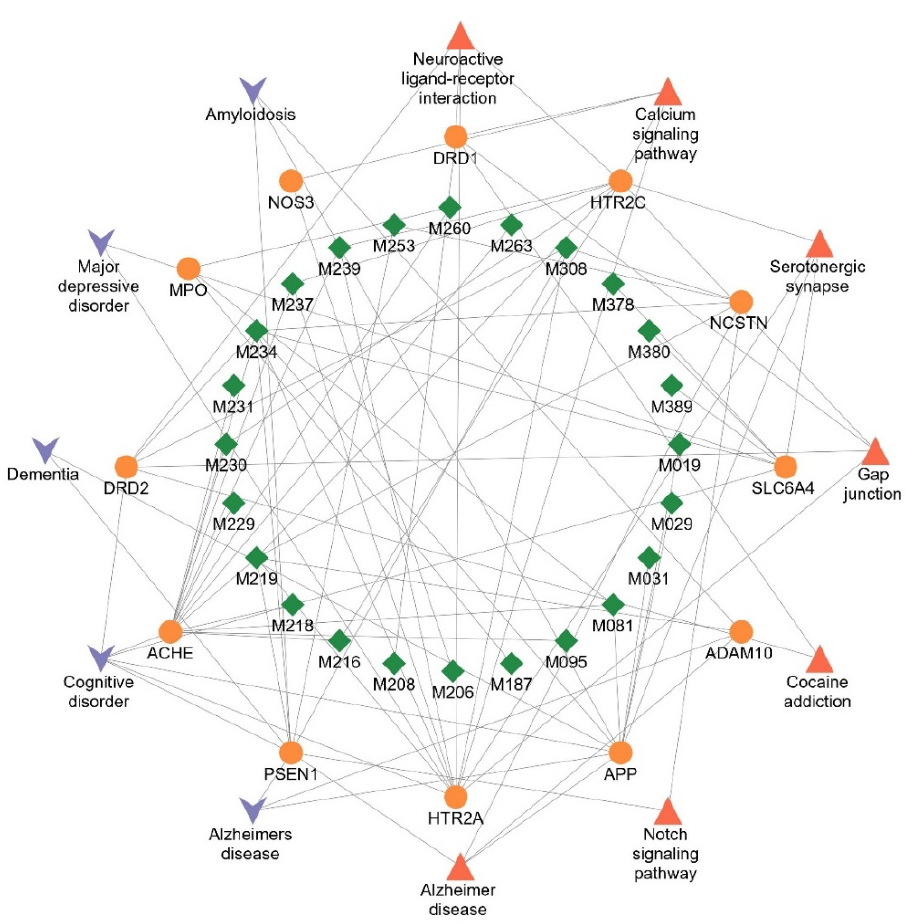
Figure 2. The compound-target-pathway/disease network of Danshen. Green diamonds denote compounds verified by molecular docking. Orange circles refer to validated targets for Danshen. Red triangles denote pathways enriched in KEGG ( FDR < 0.05). Purple V-shapes represent diseases enriched in DISEASE ( FDR <